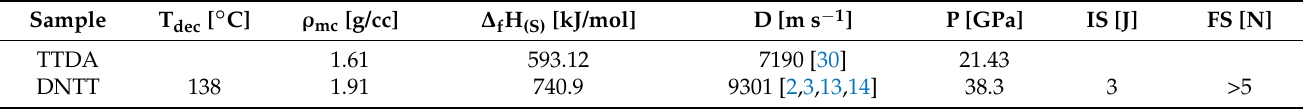
Table 1. The known characteristics of the studied high-energy compounds.